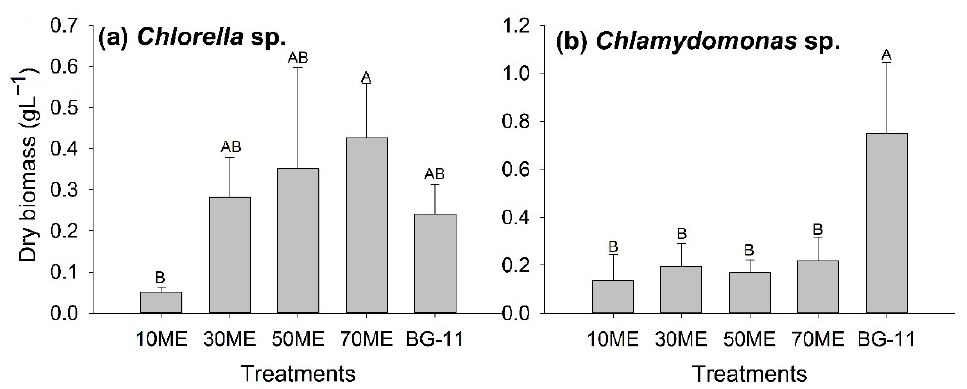
Figure 5. Variation of dry biomass ( a ) Chlorella sp. and ( b ) Chlamydomonas sp. cultivated using the diluted malting effluent and standard mineral media (BG-11) during 22 days of cultivation time. The bars represent mean biomass and errors refer to standard deviation. The statistics were derived from a one ‐ way ANOVA with post hoc Tukey test. The different letters above the bar signify the significant difference at p < 0.05.